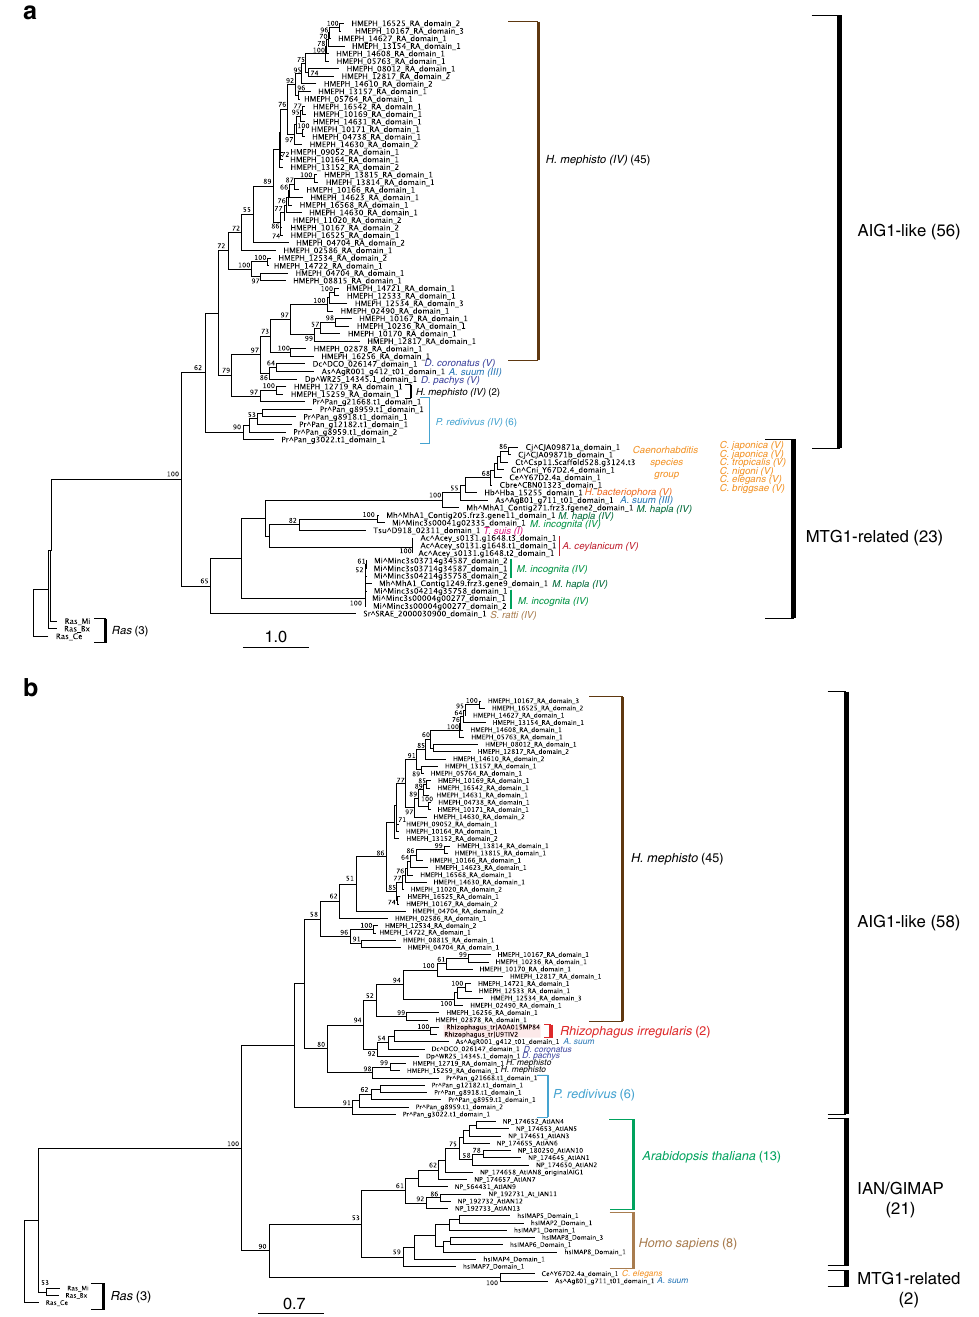
Fig. 3 Phylgenetic analysis of AIG1. a Nematode-only RAxML tree of 17 species showing two clusters: MTG1-related and AIG1-like groups. b Nematode, human, Arabidopsis , and fungal RAxML tree illustrating potential HGT event. IAN/GIMAP are synonyms of AIG1, the original names given to plant and vertebrate sequences 46 . Two fungal ( Rhizophagus irregularis ) AIG1-like sequences highlighted in light red boxes. For both trees, branch numbers indicate bootstrap support from 200 replicates, and scale bar represents substitutions per site. The sequences used in both trees are indicated with Wormbase (nematode), UniProtKB ( Rhizophagus irregularis ) or Genbank Accessions (other